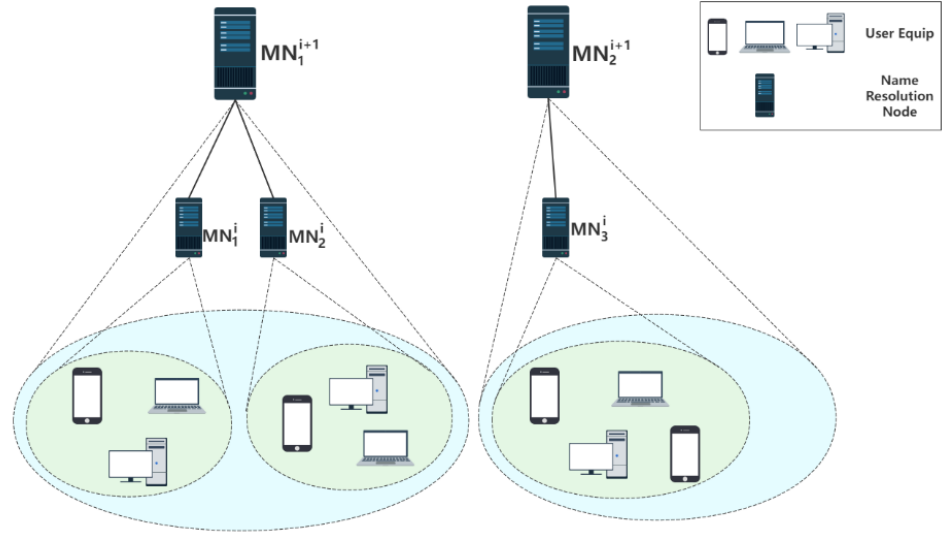
Figure 1. The nested tree structure in the local name mapping and resolution system. Users select their own master name resolution node (MN) at each service level to provide name resolution service with deterministic response latency. The user set of the MN of the same user at different levels has nesting relationships, which forms a nested tree structure.